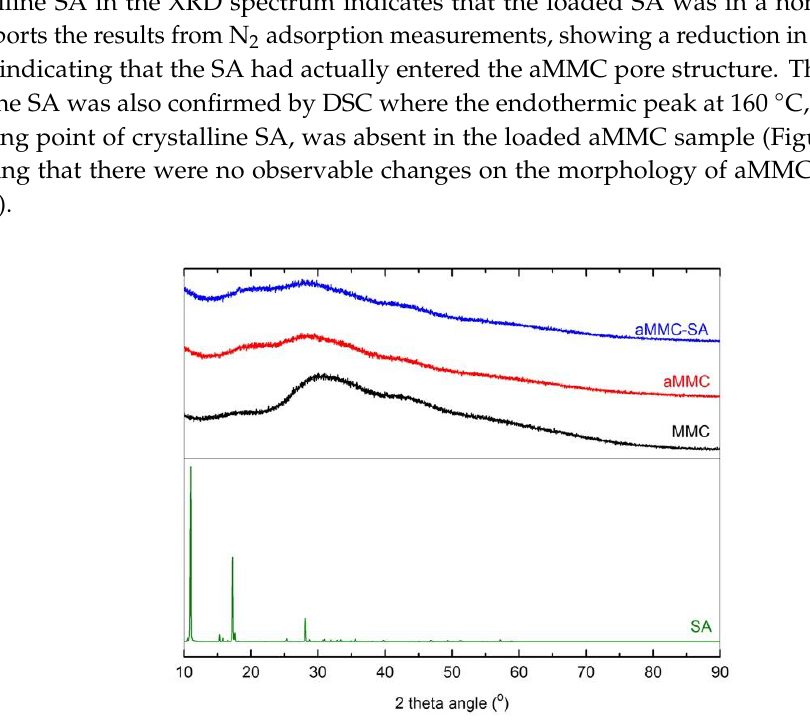
Figure 3. XRD patterns for MMC, aMMC, aMMC–SA, and pure SA.